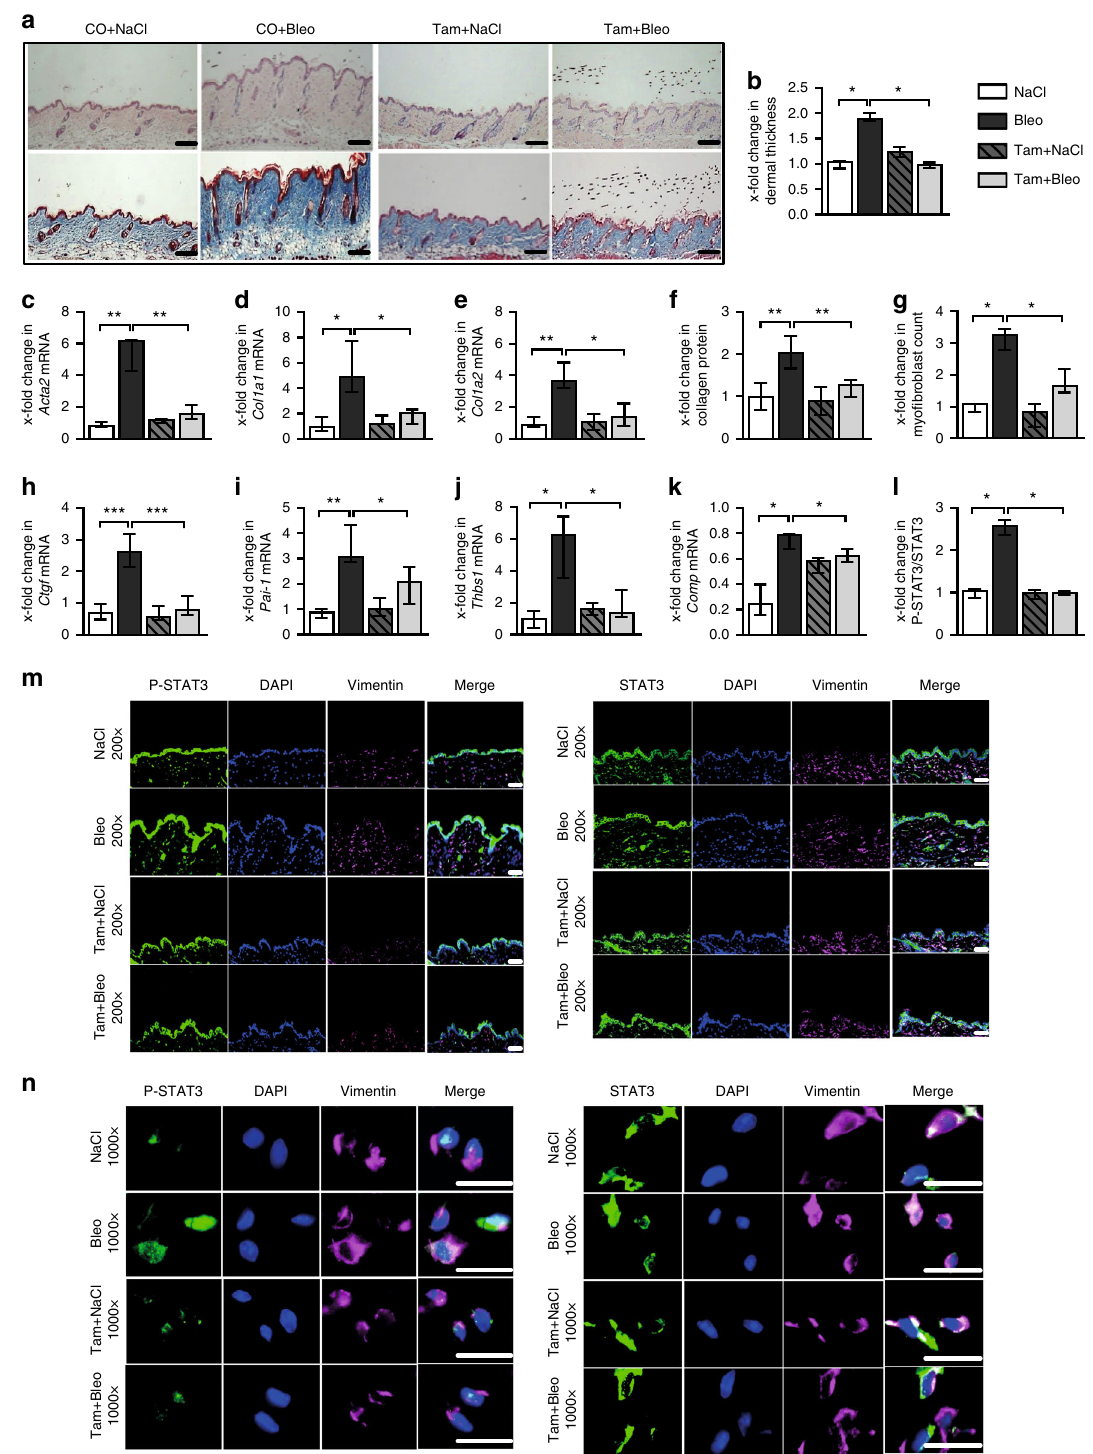
Fig. 8 Fibroblast-speci fi c knockout of STAT3 ameliorates bleomycin-induced skin fi brosis. a Representative histological sections stained with hematoxylin and eosin (top) and trichrome (bottom). b Dermal thickness, c – e mRNA levels of Acta2 , Col1a1 , and Col1a2 , respectively, f hydroxyproline content, g myo fi broblast count, and h – k levels of h Ctgf mRNA, i Pai-1 mRNA and of the proposed biomarkers, j Thbs1 mRNA, and k Comp mRNA. m , n Representative immmuno fl uorescence stainings of P-STAT3 (left) and total STAT3 (right) at 200-fold and 1000-fold magni fi cation, respectively, along with their l quantitative analyses. All experiments were performed in the skin tissue sections from the experimental mouse model of bleomycin-induced skin fi brosis in mice with fi broblast-speci fi c, tamoxifen-inducible, Cre-loxP-based ( Col1a2-Cre-ER ) knockout of STAT3 in STAT3 fl / fl mice and control littermates (C57Bl/6background, 12 weeks of age). N ≥ 6 mice with 2 technical replicates per group for all experiments. Results are shown as median ± interquartile range (IQR). Horizontal scale bar, 100 μ m. Signi fi cance was determined by Mann – Whitney test, as compared to vehicle-treated, fi brotic mice, respectively. * P < 0.05; ** P < 0.01***; P < 0.001. Tam tamoxifen, CO